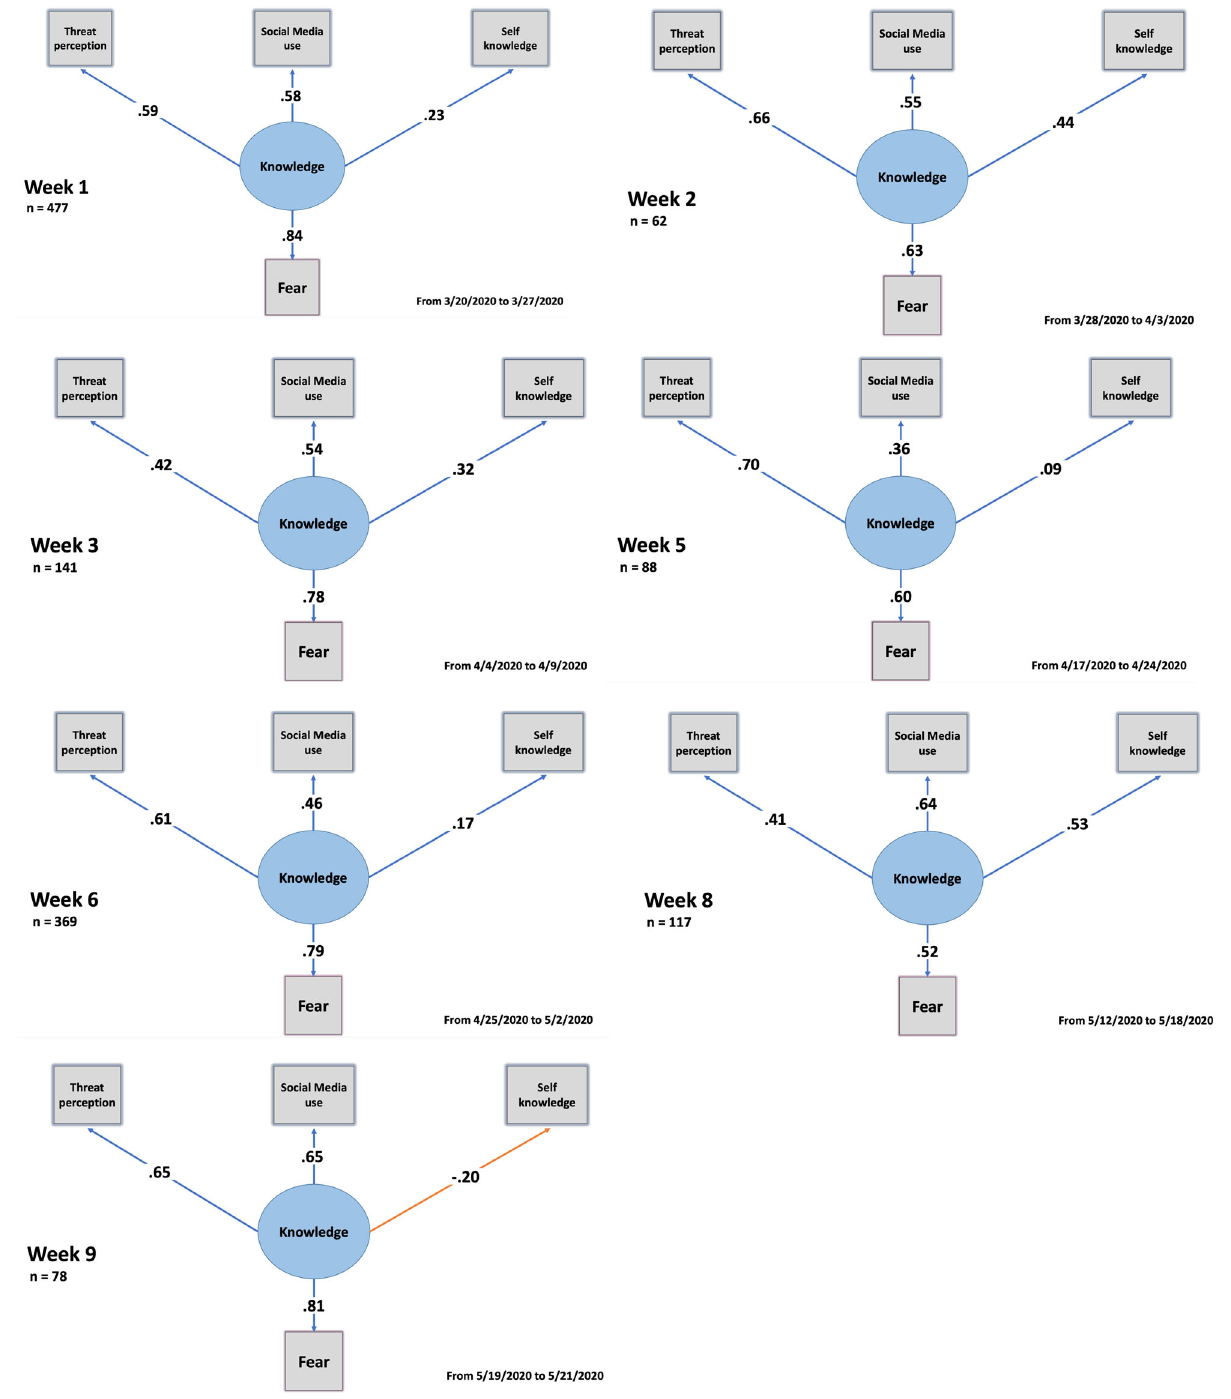
Fig. 1 Illustration of the Structural Equation Model. SEM model with standardized structural coef fi cient estimates of the relationship between the independent variables, the latent variable “ perceived knowledge ” , and Fear in each